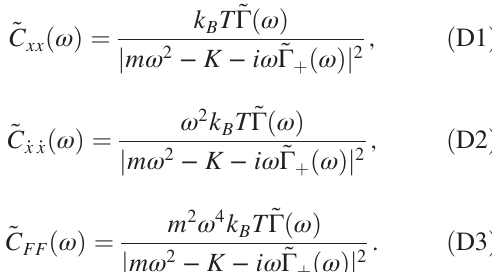
FIG. 10. Comparison of the methane friction coefficient γ ¼ γ þ γ þ γ 1 2 3 with its contributions function of K . We also show the sum of the short time contributions γ 1 þ γ 2 .